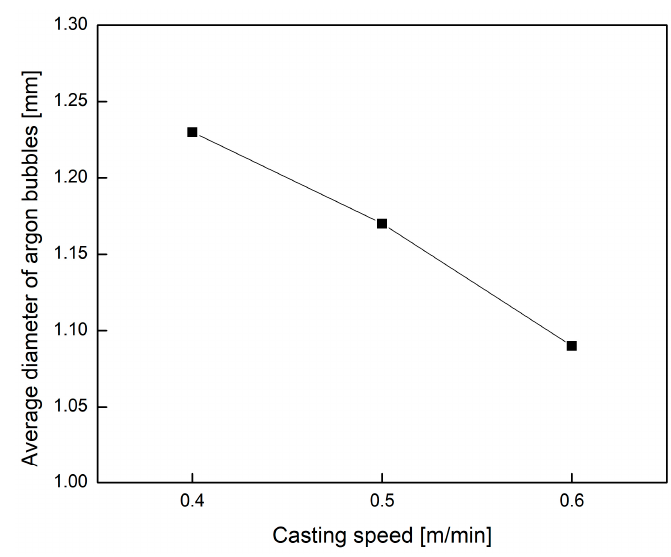
Figure 8. Average diameter of argon bubbles on the inner surface of the nozzle for different casting speeds.